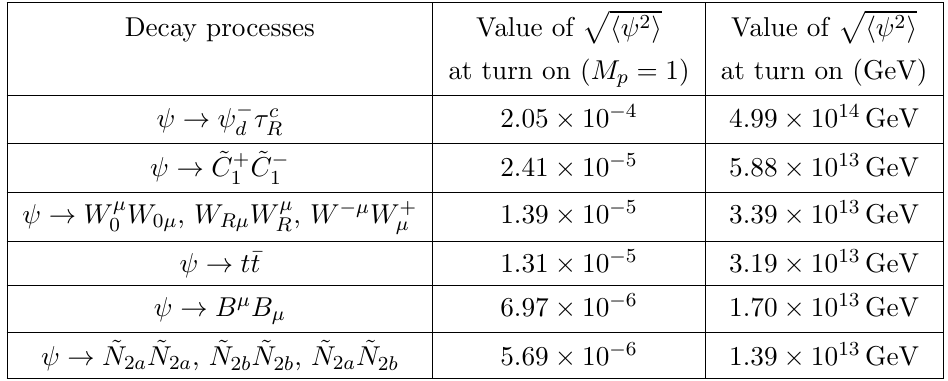
p Table 3. Values of h 2 i at which each decay process is turned on. We use the Yukawa couplings evaluated at the reheating scale of order 5 : 8 (cid:2) 10 13